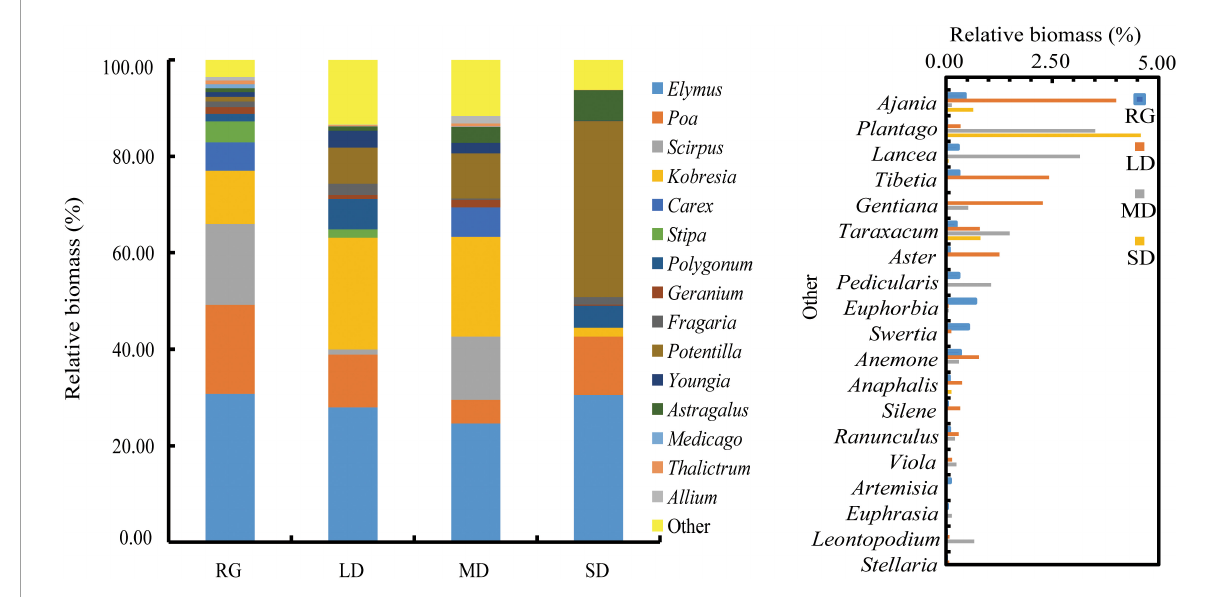
FIGURE3 Relative biomass of plants at the genus level. LD, lightly degraded grassland; MD, moderately degraded grassland; SD, severely degraded grassland; RG, reseeded grassland.